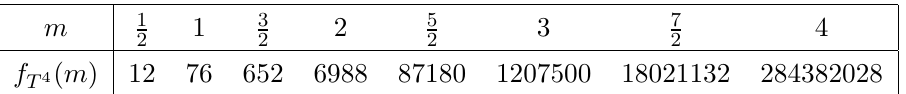
Table 3 . First few values of f